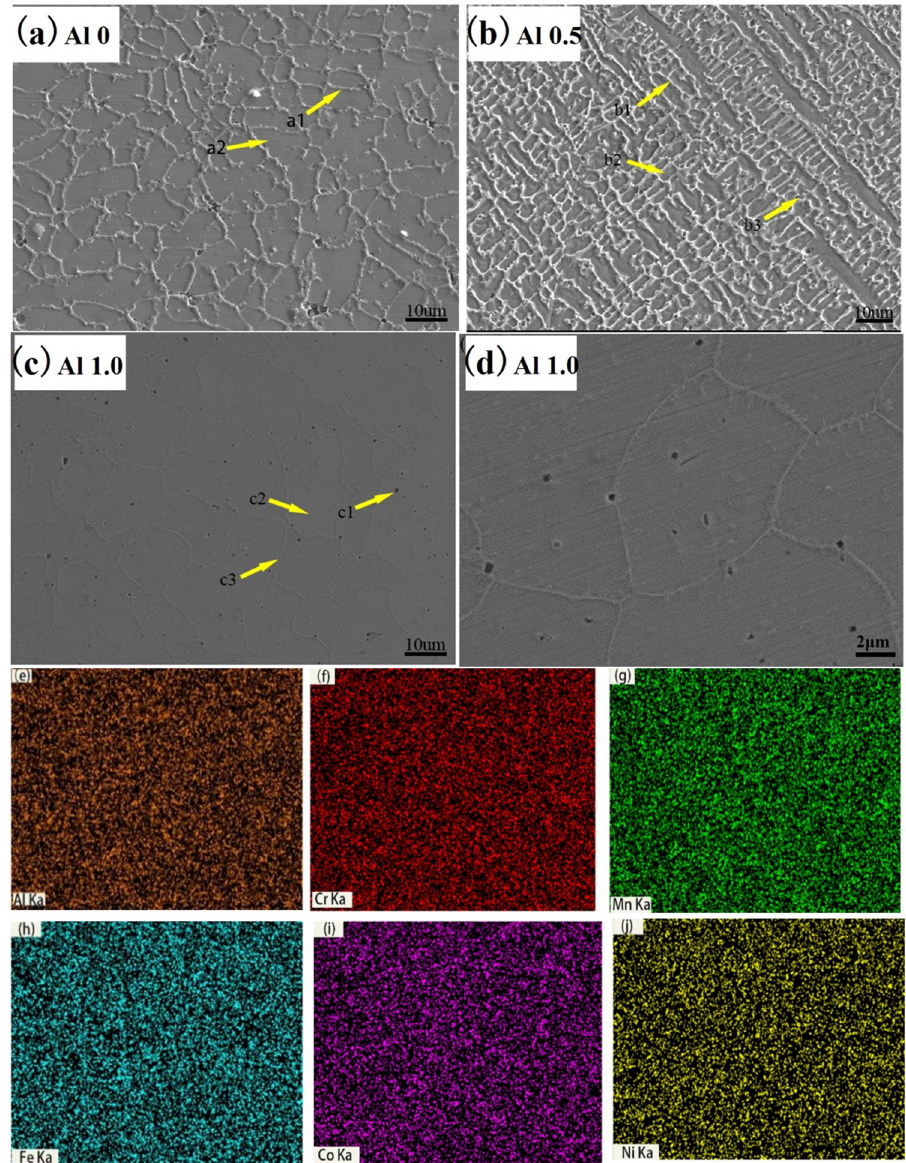
Figure 4. SEM results of cladding layer and surface scanning results of Al1.0 (a) x = 0 (b) x = 0.5 (c) x = 1.0 (d) x = 1.5 (e-j) x = 1.0 cladding laye.